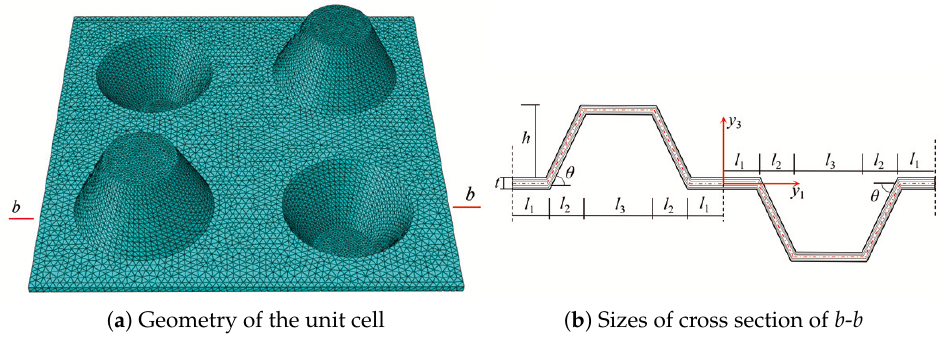
Figure 15. Geometry and sizes of typical unit cell within bidirectional CCCP.